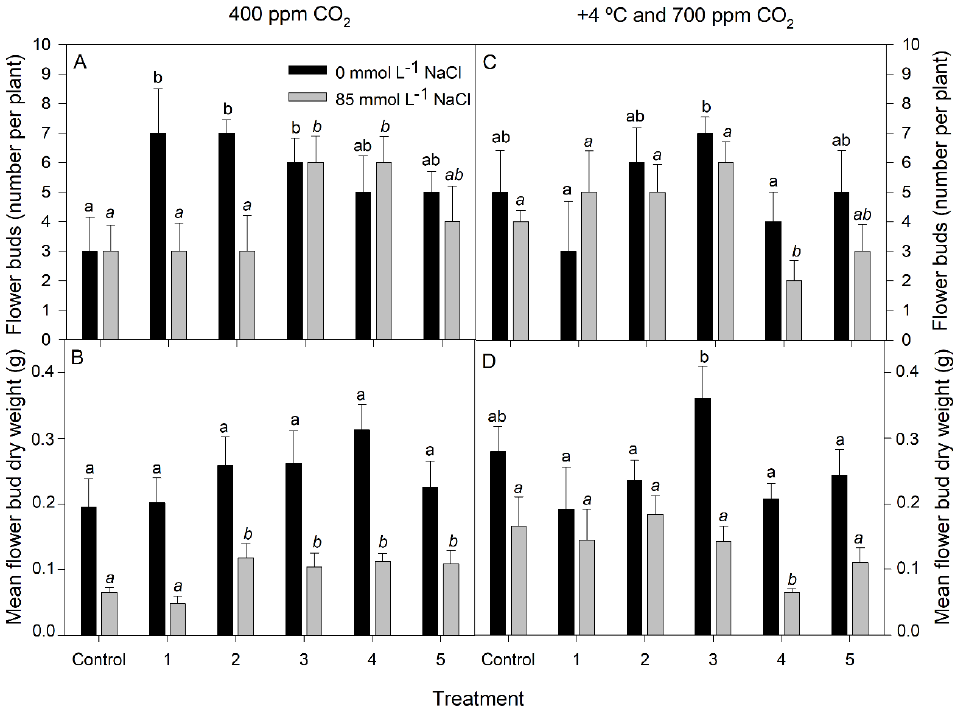
Figure 2. Number of flower buds per plant ( A , C ) and the mean dry weight of flower buds ( B , D ) of strawberry plants inoculated with rhizobacteria consortia, numbered 1 to 5 (control = non-inoculated plants), after 30 d of treatment at 400 ppm CO 2 ( A , B ) and at +4 °C and 700 ppm CO 2 ( C , D ) with 0 and 85 mmol L − 1 NaCl. Each value represents the mean of ten replicates ± SE. Different letters for each saline treatment (capital and italic letters for 0 and 85 mmol L − 1 NaCl, respectively) indicate those means that are significantly different from each other (GLM; Duncan test, p < 0.05).